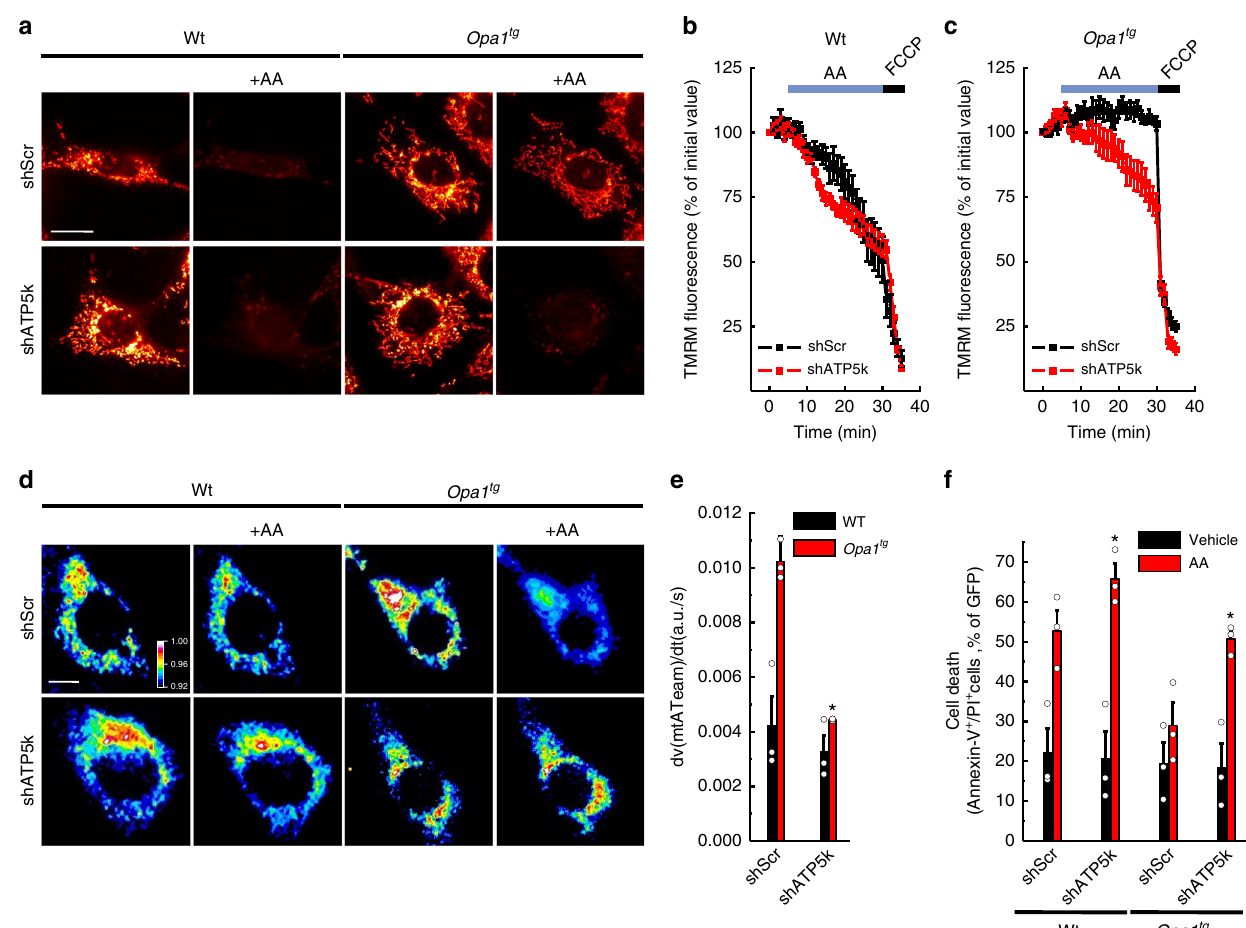
Fig. 7 OPA1 requires ATP5k to protect from mitochondrial dysfunction. a Representative pseudocolor-coded frames from real time imaging of TMRM fl uorescence in MAFs of the indicated genotype transfected with the indicated shRNA. Where indicated, cells were incubated with antimycin A (AA) (2 µ